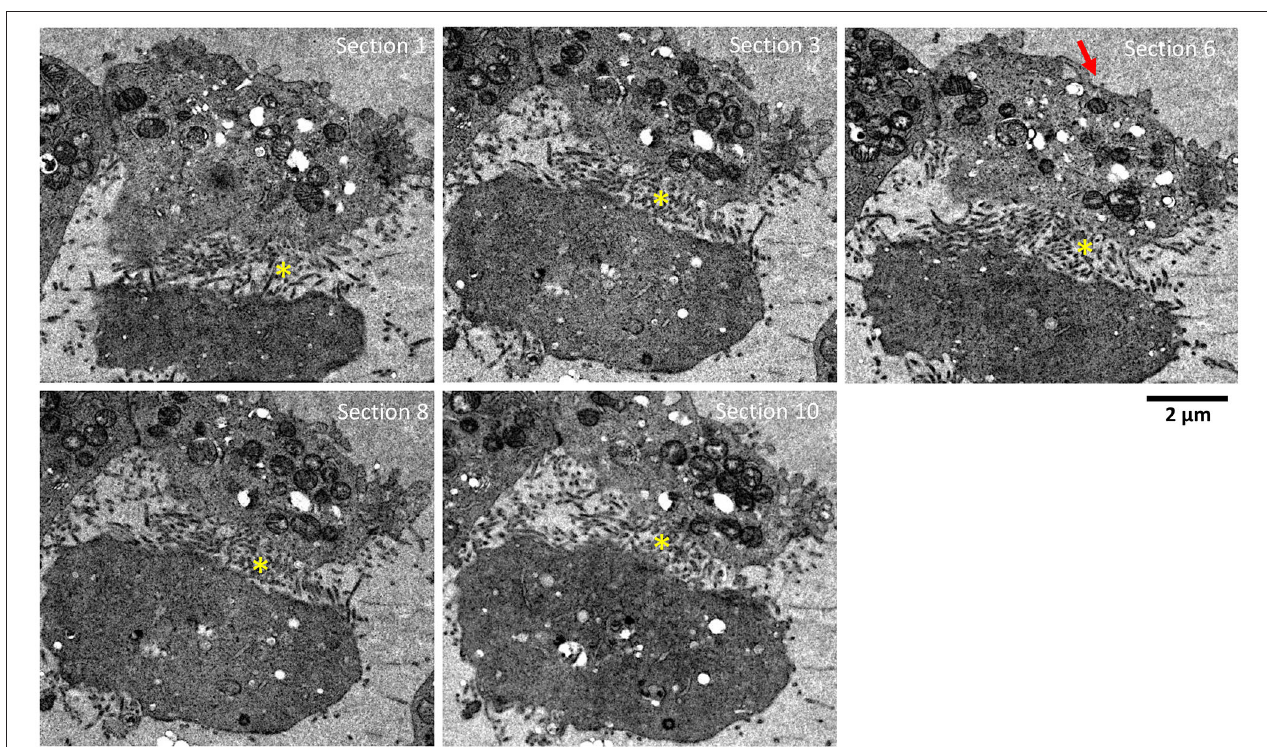
FIGURE 3 | Serial sections showing adjacent HTNV-infected Vero E6 cells. Serial sections, 90nm thick, through HTNV-infected Vero E6 cell at 9 dpi. Successive sections show lots of projections only in areas between neighboring infected cells. These sections are visible in multiple cells in contact. The depth of sample covered was about 1 µ m. Yellow (*) indicates the area between two cells with multiple plasma membrane projection contacts from both cells putatively sequestering viruses. Red arrow indicates area of cells not in contact with adjacent cells and devoid of plasma membrane